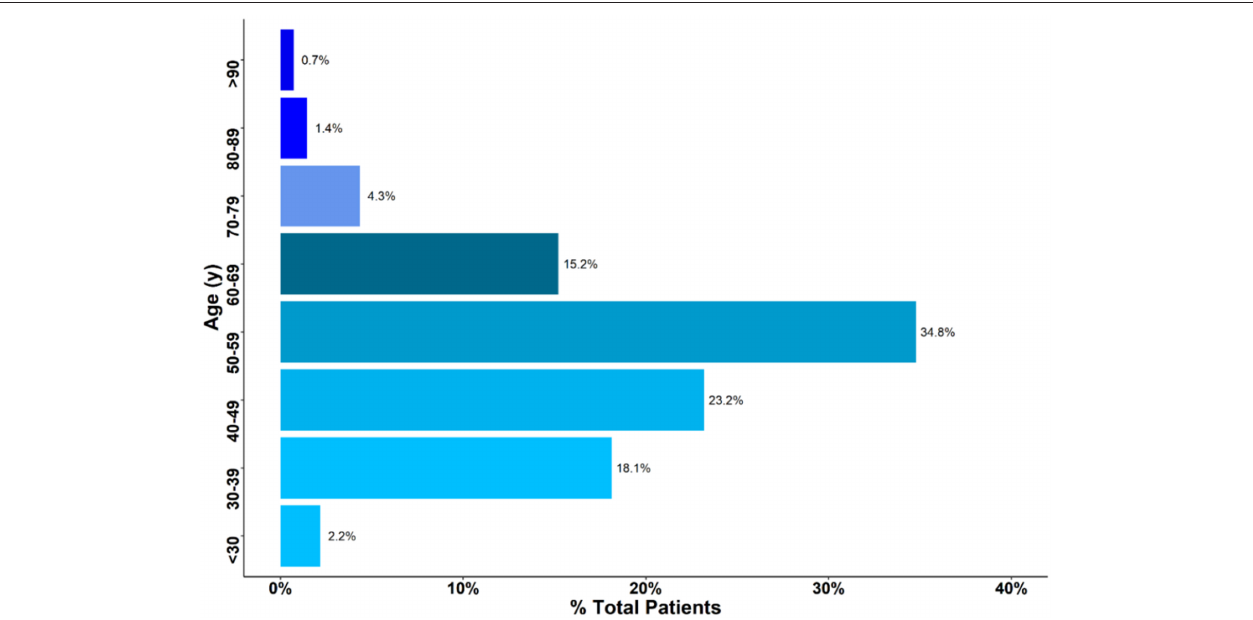
FIGURE 1 | Age of patients presenting with breast cancer. Approximately 76% of Patients were between 30 and 60 years.